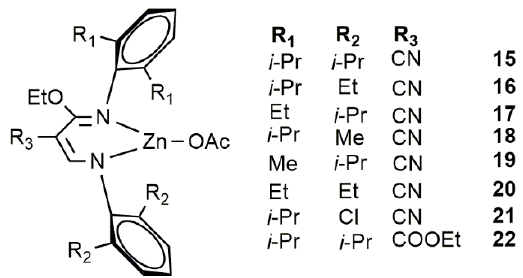
Figure 9. (AIA)Zn(OAc) complexes 15 – 22 [43].